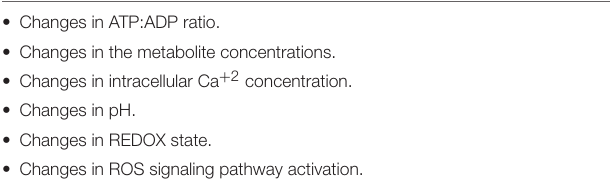
TABLE 1 | Lists of the skeletal myocyte physiological stimuli during